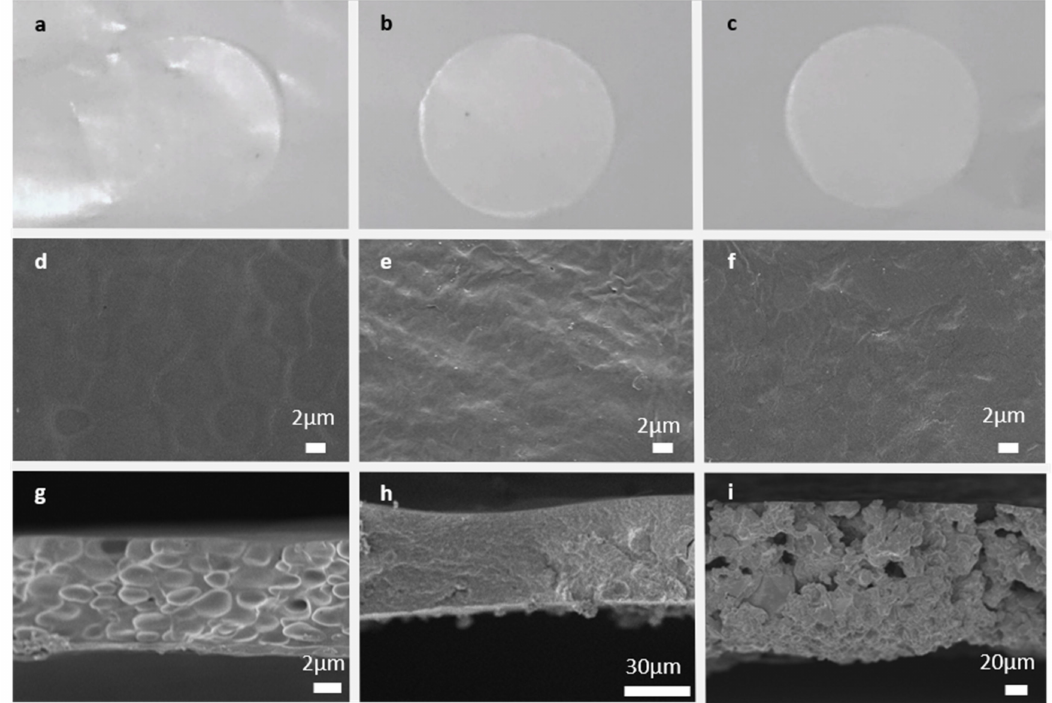
Figure 2. Pictures of the different CGPEs: without NS ( a ), with 5 wt% NS ( b ), with 10 wt% NS ( c ). FESEM micrographs of the surface of CGPE without NS ( d ), CGPE with 5 wt% NS ( e ), CGPE with 10 wt% NS ( f ). FESEM micrographs of the cross-section of CGPE without NS ( g ), CGPE with 5 wt% NS ( h ), CGPE with 10 wt% NS ( i